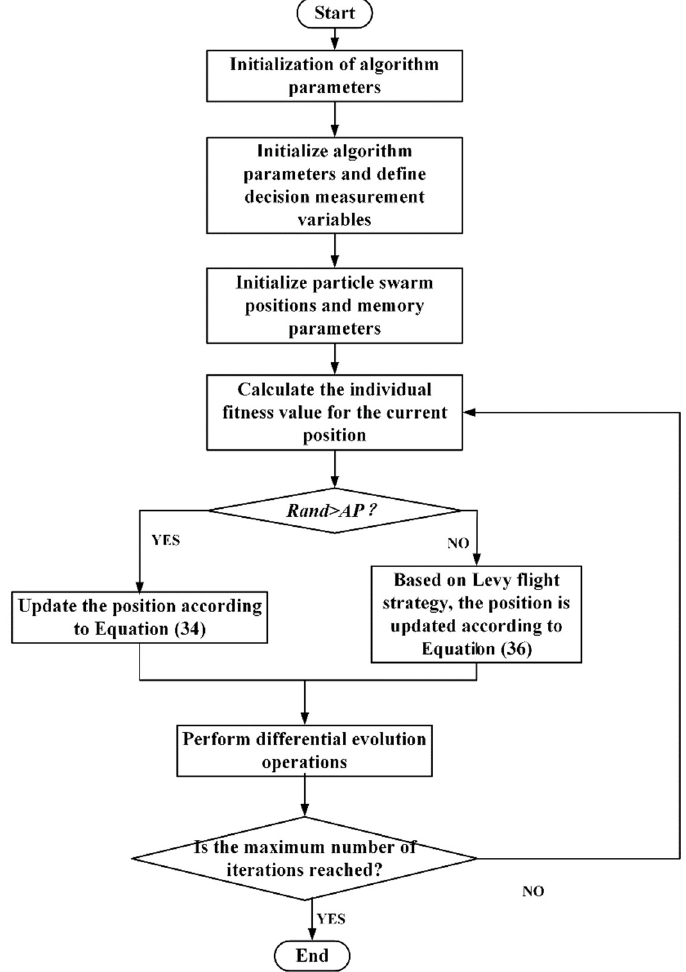
Figure 1. Implementation of the LDMOPSO algorithm.